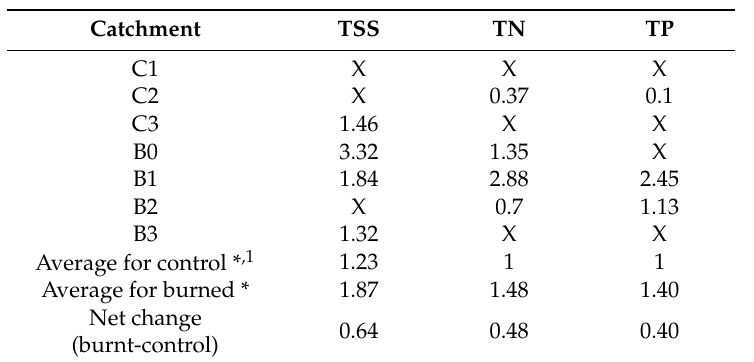
Table 9. Back-transformed model coefficients for wildfire dummy variable, indicating effects of wildfire on